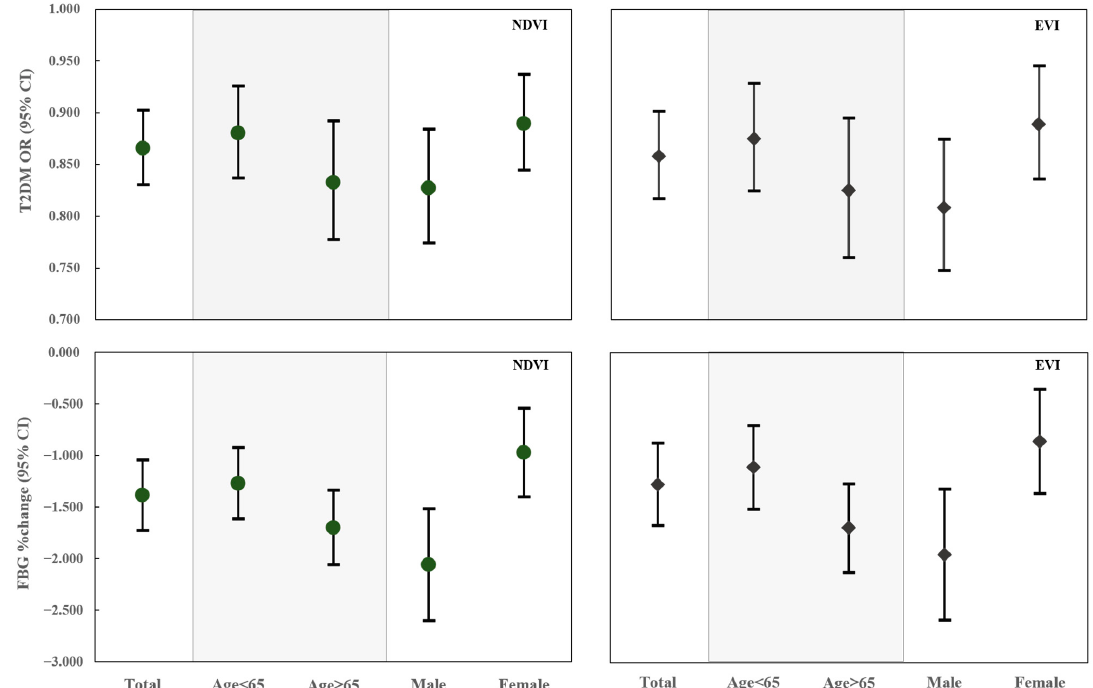
Figure 2. Interaction effects of potential confounders in associations between residential green space and type 2 diabetes mellitus and fasting blood glucose levels. Models were adjusted for age, sex, body mass index, education level, marital status, monthly income, smoking, drinking, high-fat diet, fruit and vegetable intake, physical activity, and family history of